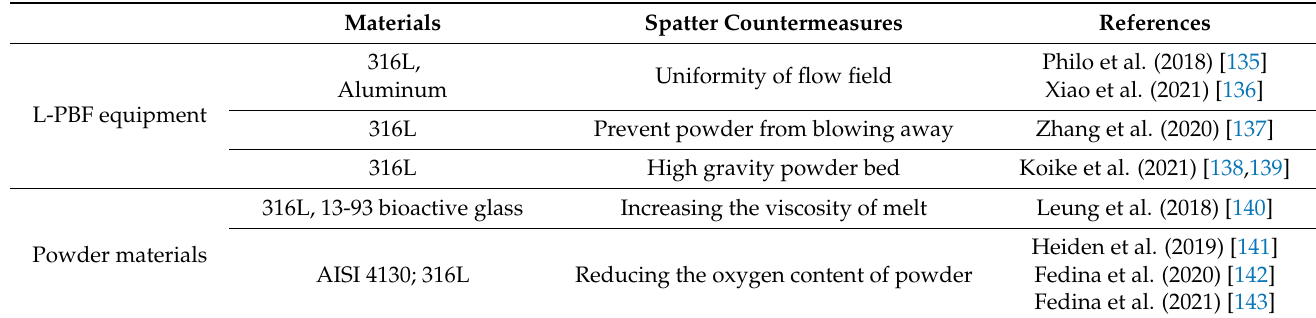
Table 10. A summary of the research on L-PBF equipment and materials.